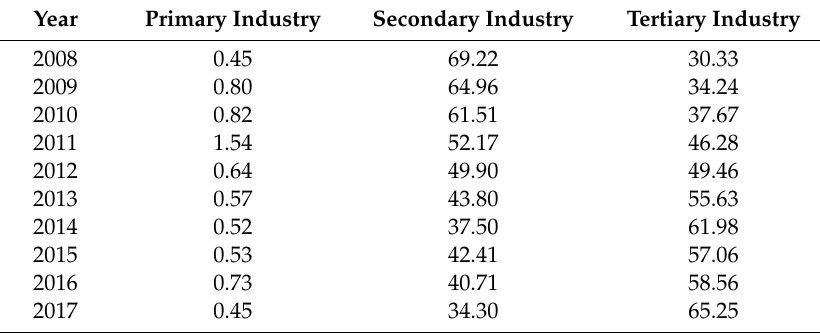
Table 1. Industries structure of FDI in Zhejiang Province (2008 to 2017) (%).